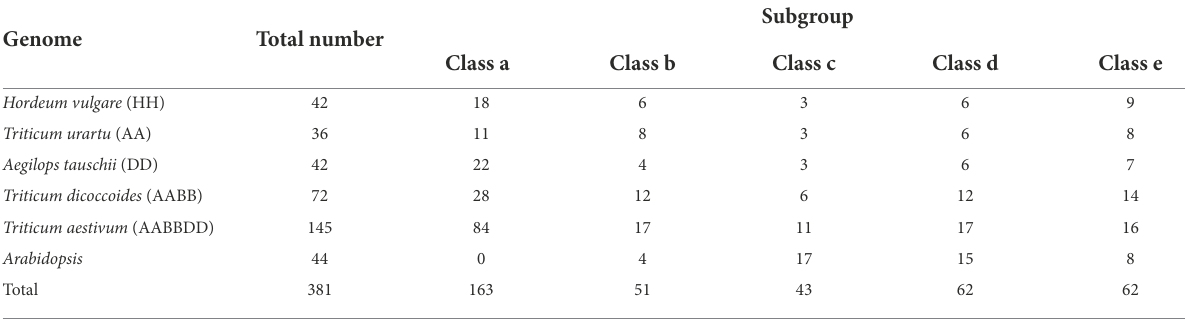
TABLE 1 Numbers of ANKTMs in the five analyzed Triticeae species and Arabidopsis genomes in total and each class.